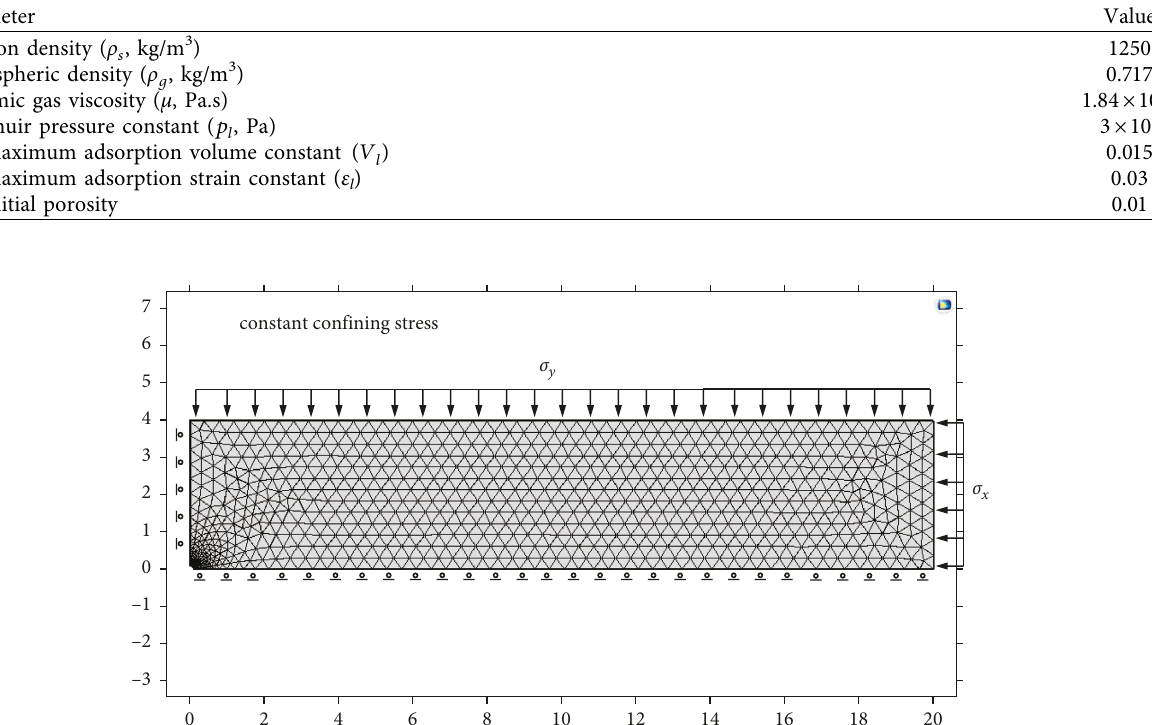
Figure 6: Schematic of the 2D model for simulating field gas production. Table 1: Input parameters used in the numerical model in Yang et al. [2].